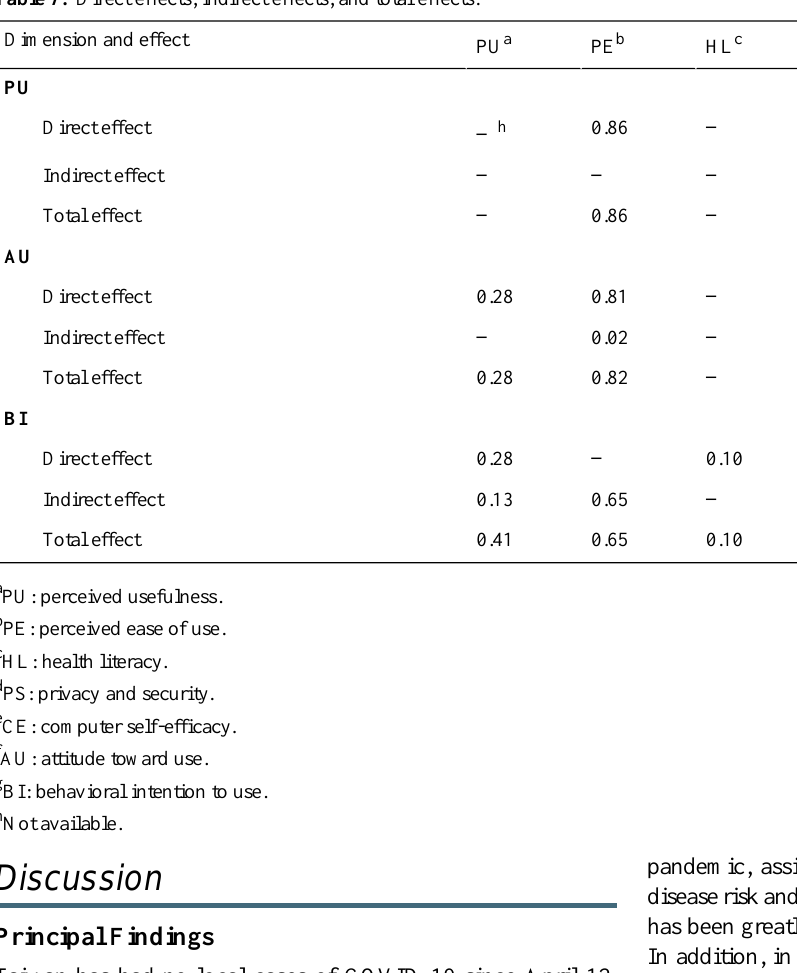
Table 7. Direct effects, indirect effects, and total